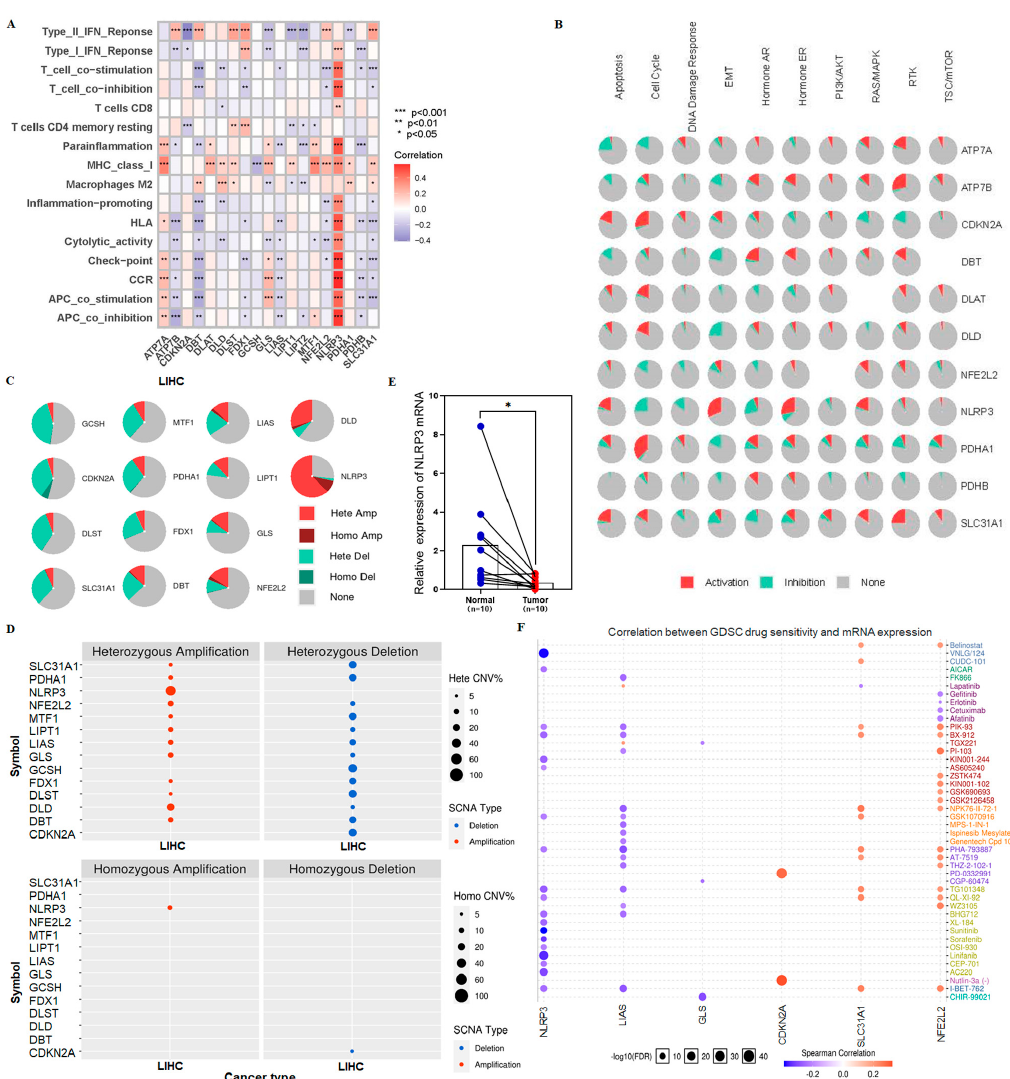
Figure 10. The analysis of drug sensitivity in high-risk group. ( A ) The heatmap of correlation between cuproptosis-related genes and 22 immune cells and immune-related functions. ( B ) The pathways pie chart of cuproptosis-related genes, with red representing activation and green representing inhibition. ( C ) The pie charts of cuproptosis-related genes with CNV in HCC. ( D ) The CNV status of the cuproptosis-related genes in heterozygous and homozygous HCC patients was shown above and below the figure, respectively. ( E ) The differential analysis plots show the expression of NLRP3 in HCC tissue and adjacent normal tissue from HCC patients. ( F ) The correlation between cuproptosis- related gene expression and sensitive targeted therapy drugs obtained by the spearman correlation analysis. The red represents positive correlation, indicating that the gene is highly expressed and resistant to drugs, whereas the blue represents the drug sensitivity of the gene. * p < 0.05, ** p < 0.01, and *** p <